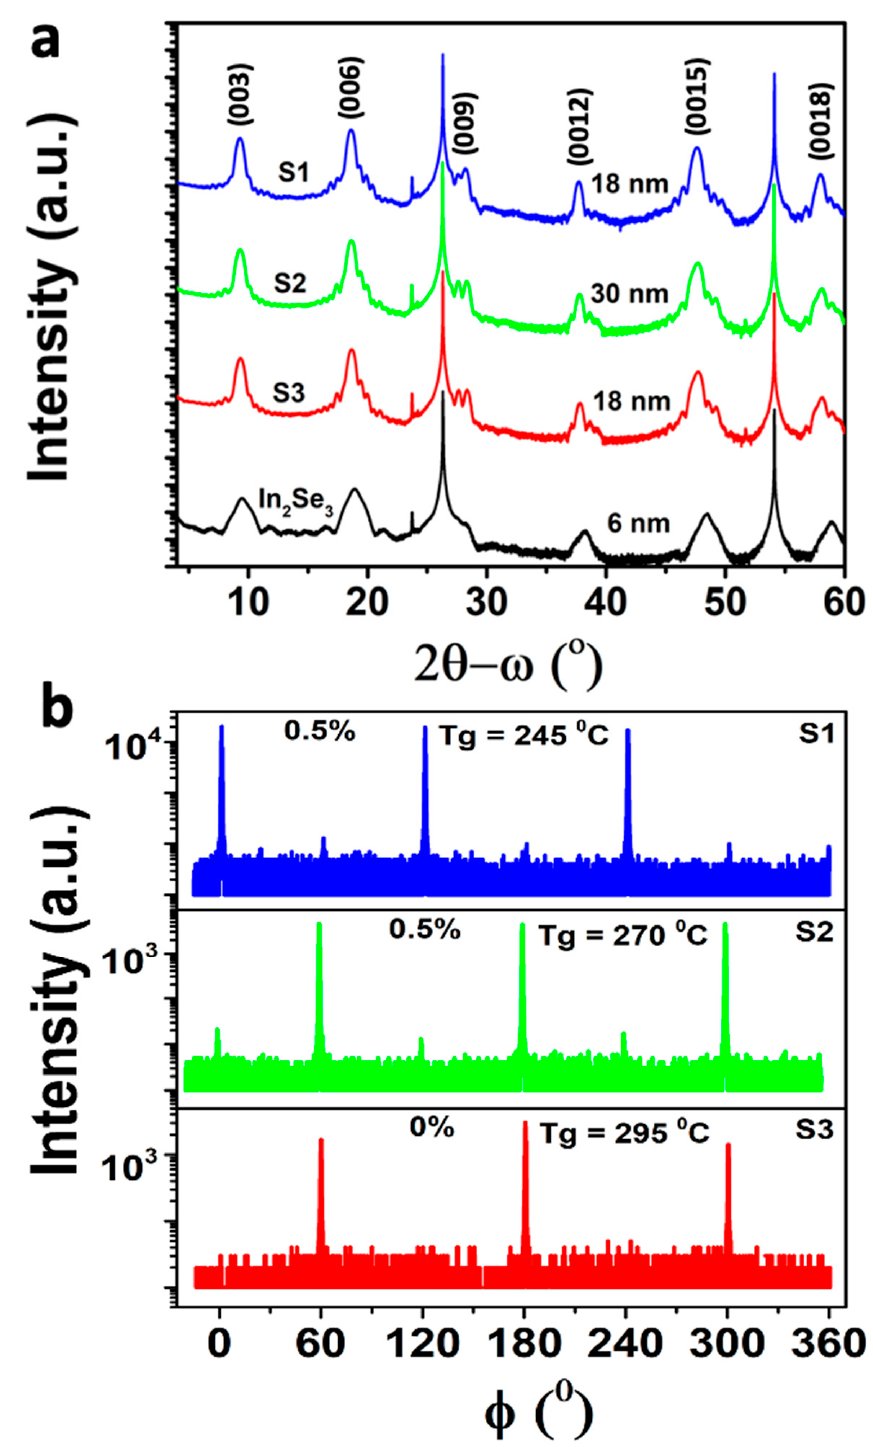
Figure 4. X-ray diffraction (XRD) ( a ) 2 θ - ω scans of Bi 2 Se 3 films with different thicknesses grown at Figure 4. X-ray di ff raction (XRD) ( a ) 2 θ - ω scans of Bi 2 Se 3 fi lms with di ff erent thicknesses grown at different substrate temperatures (T g ) on In 2 Se 3 layer. ( b ) φ scan of (015) plane of the samples shown di ff erent substrate temperatures (T g ) on In 2 Se 3 layer. ( b ) ϕ scan of (015) plane of the samples shown in ( a ) with the calculated twinning in ( a ) with the calculated twinning percentages.